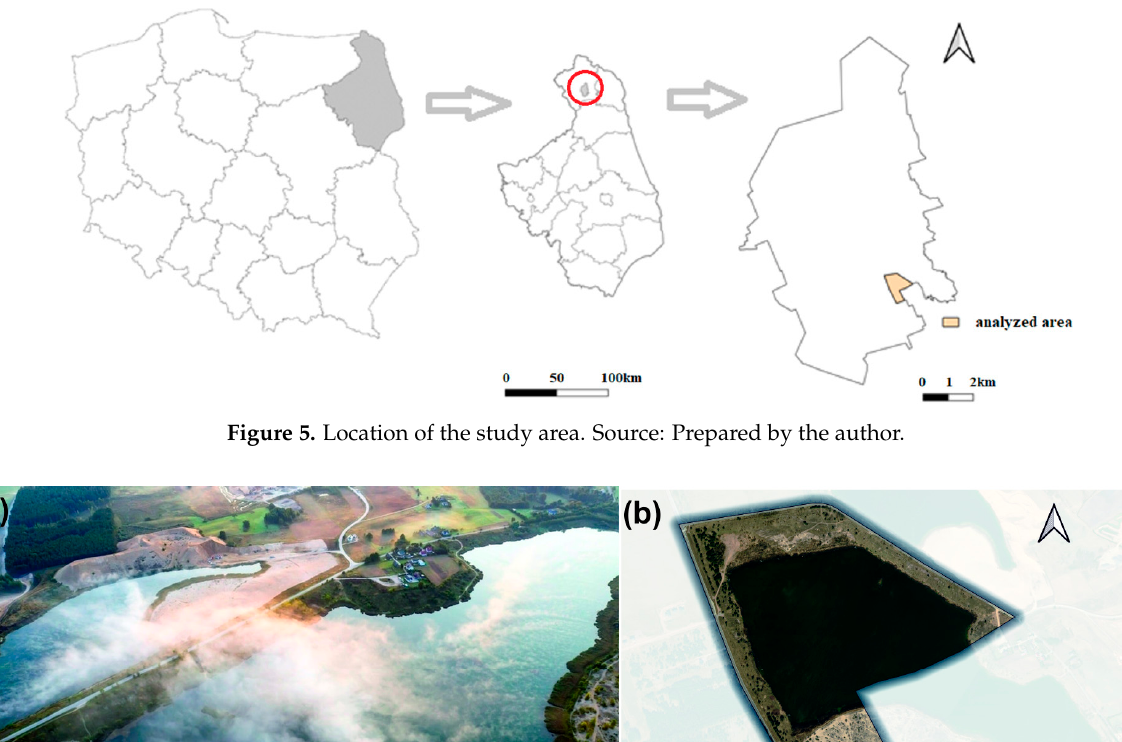
Figure 5. Location of the study area. Source: Prepared by the author.